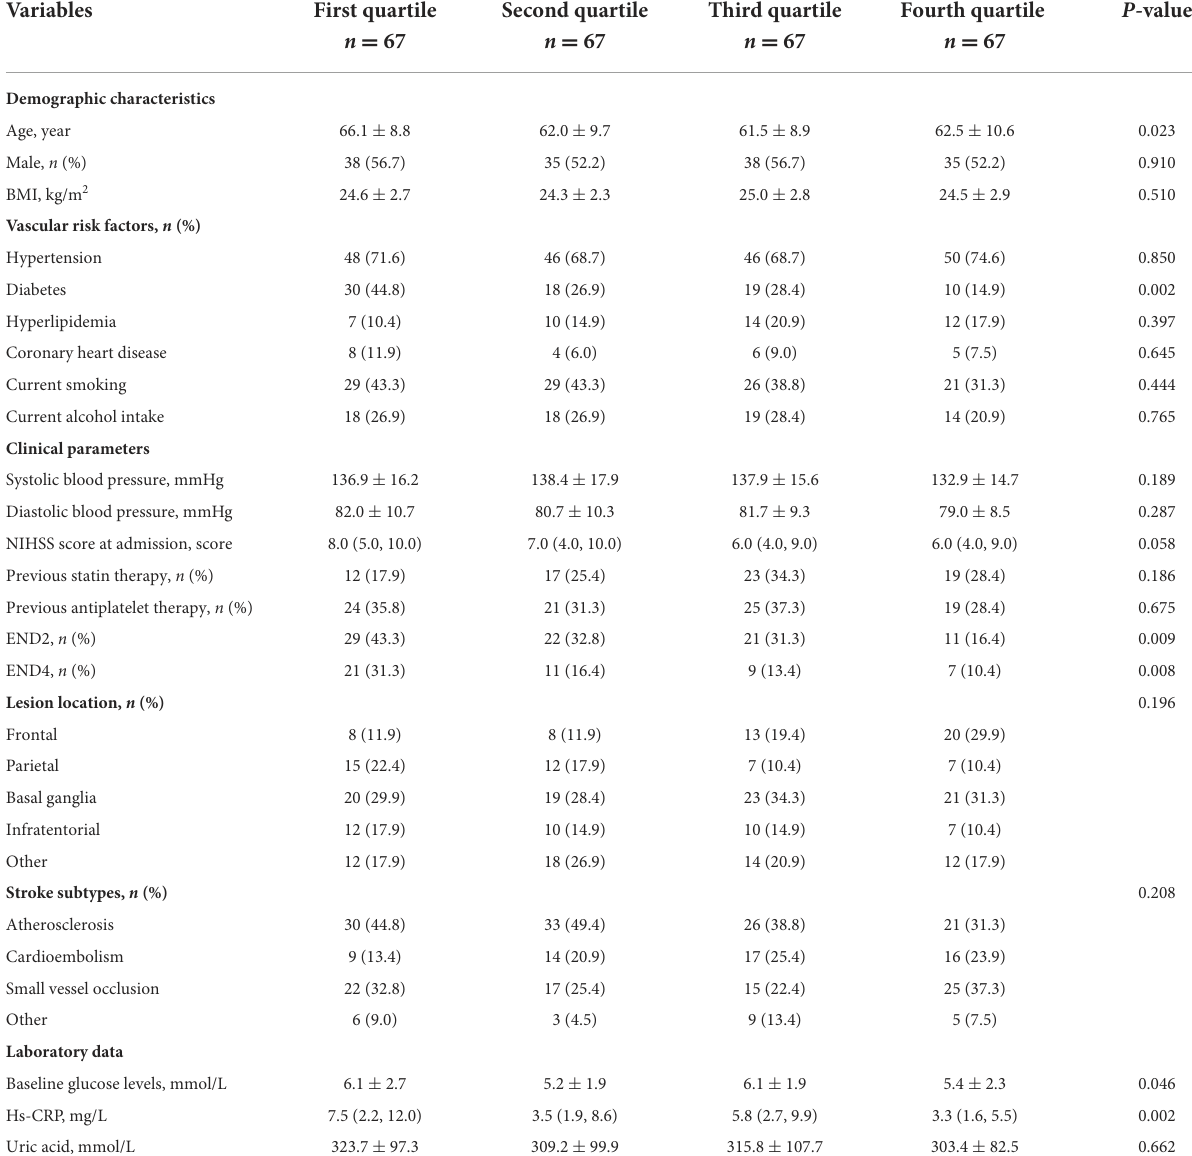
TABLE 1 Baseline data according to the quartile of netrin-1